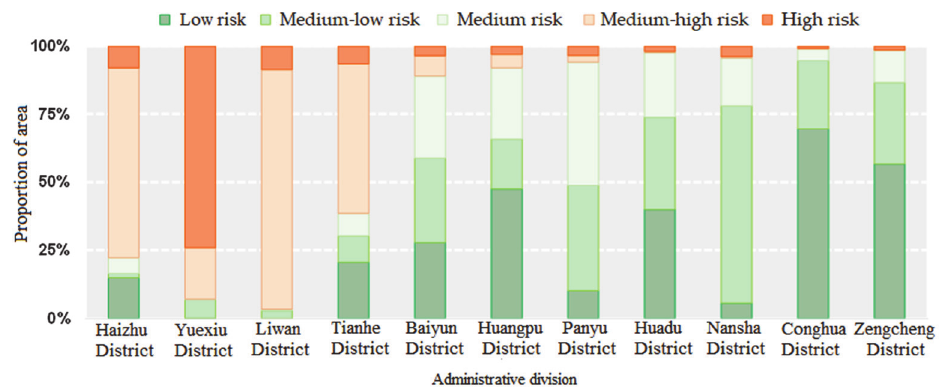
Figure 11. Statistics of the waterlogging disaster risk levels in various administrative regions of Guangzhou.